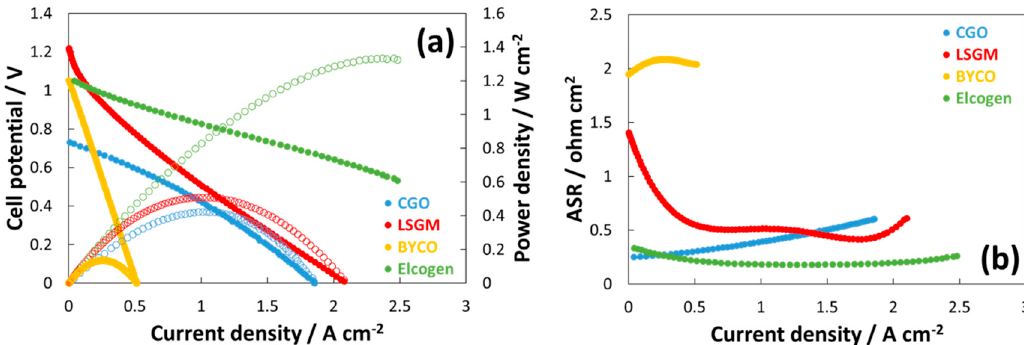
Figure 3. Polarization and ASR curves at 800 °C for the modified perovskite-based cells fed with H 2 using three supporting electrolyte based Solid Oxide Fuel Cells (SOFCs) (e.g., CGO, LSGM, and BYCO) and a commercial Elcogen cell coated at the anode with an exsolved perovskite pre-layer. ( a ) Cell potential and power densities vs. current density; ( b ) area specific resistance vs. current density. (Standard deviation was < 7 mV for each data point of the overall polarization dataset).